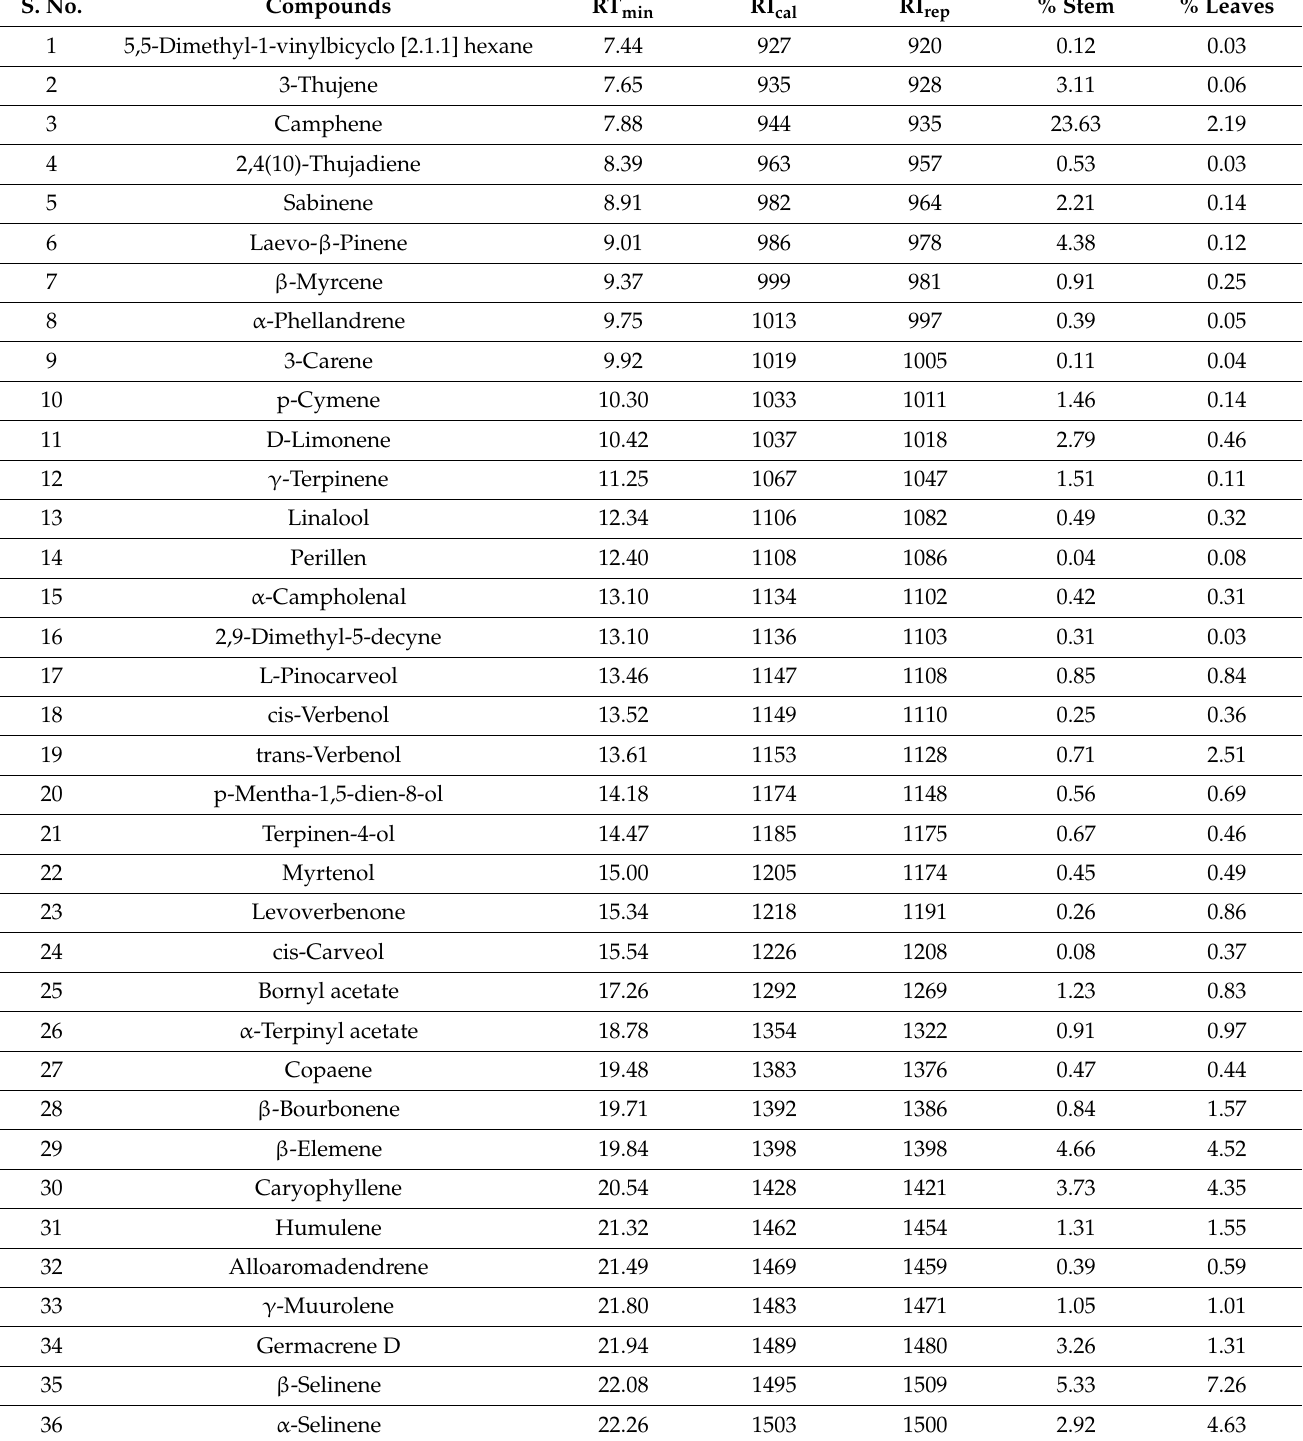
Table 1. The GC-MS analysis of the EOs of Blepharispermum hirtum